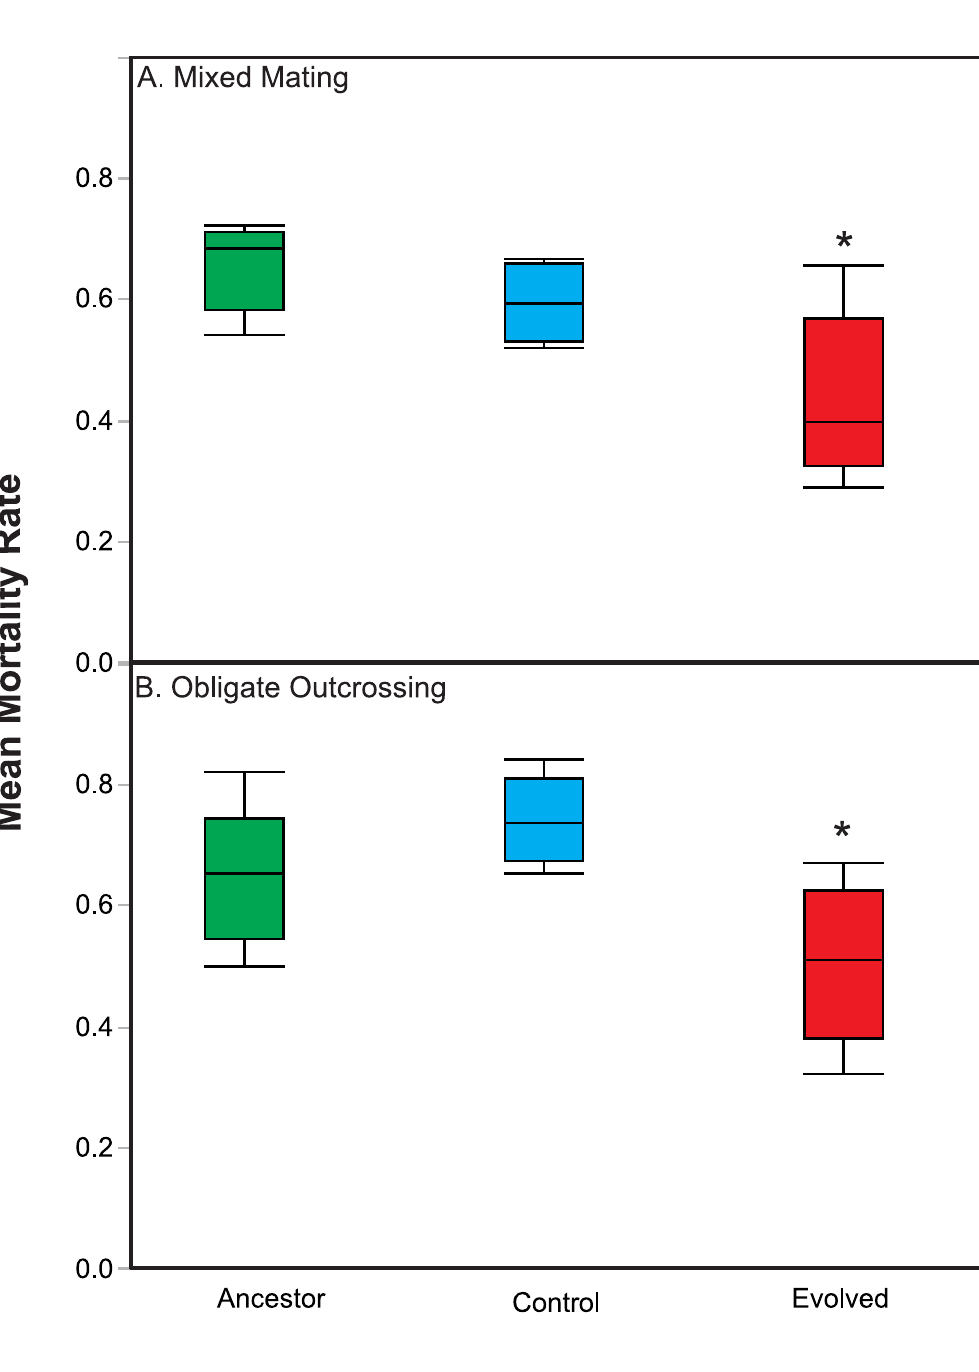
Fig 2. Host defense during exposure to S . marcescens . Populationsevolved under the Control and Evolution treatments, as well as Ancestral populations, were exposedto S . marcescens on SSPs for 48 hours and then host mortality rates were assessed. (A) Mixed mating populationsfrom the Evolution treatment exhibitedreduced mortality rates. (B) Obligatelyoutcrossingpopulationsfrom the Evolution treatment exhibitedreducedmortality rates. Overall, persistent exposureto the parasiteselectedfor the evolutionof increasedhost defense regardlessof the host mating system.